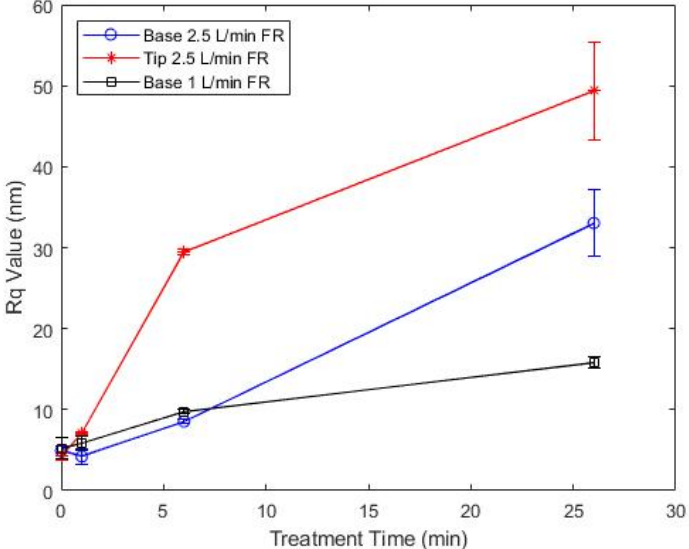
Figure 7. Rq roughness measurements measured by AFM and analyzed by NanoScope Analysis ( NanoScope Analysis (32 bit) , version 1.50 (Build B72.115792); Bruker Corporation: 2015.).